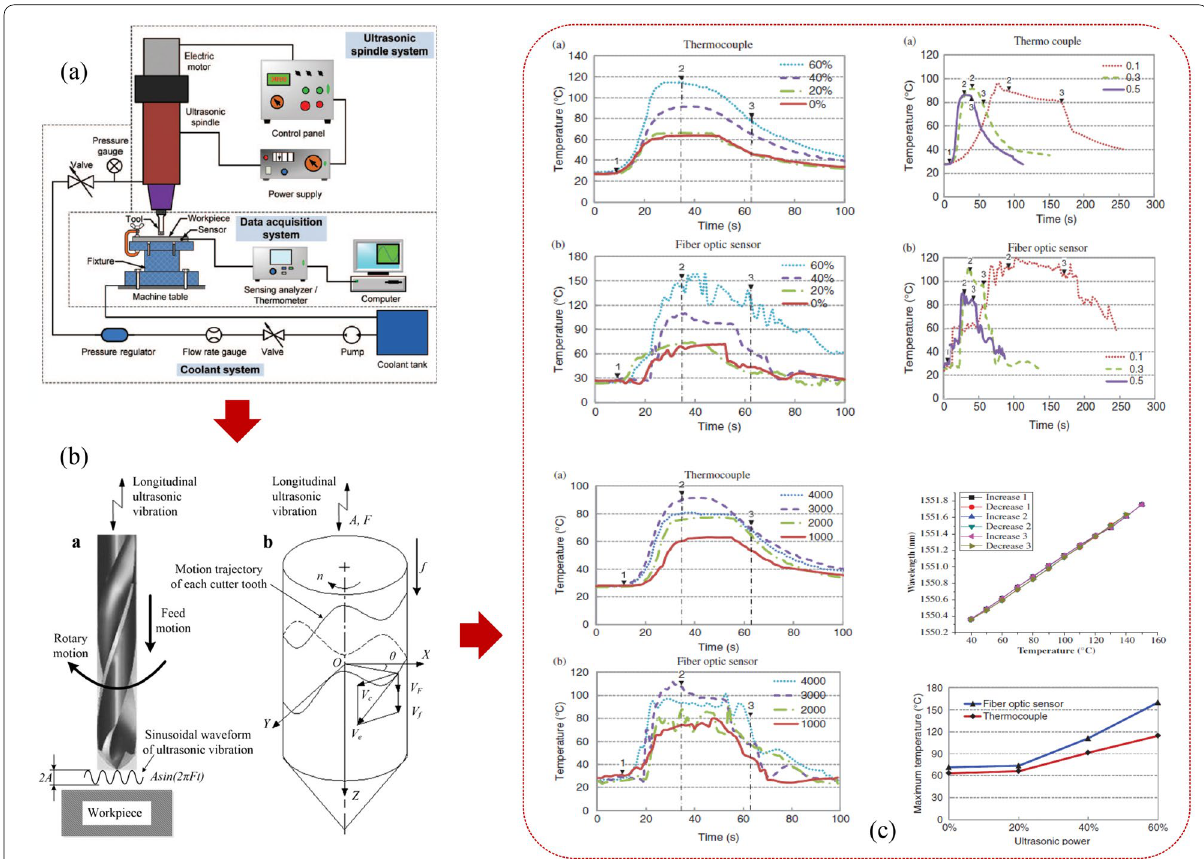
Figure 25 Results of UAD system: a schematic of experimental system, b schematic of UAD process and trajectory of each cutter tooth on the drill, c influence of different factors on ultrasonic vibration drilling temperature [119,